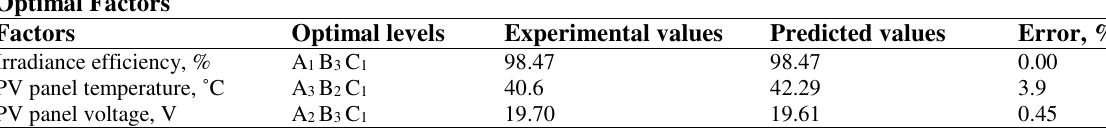
Results of Confirmation.